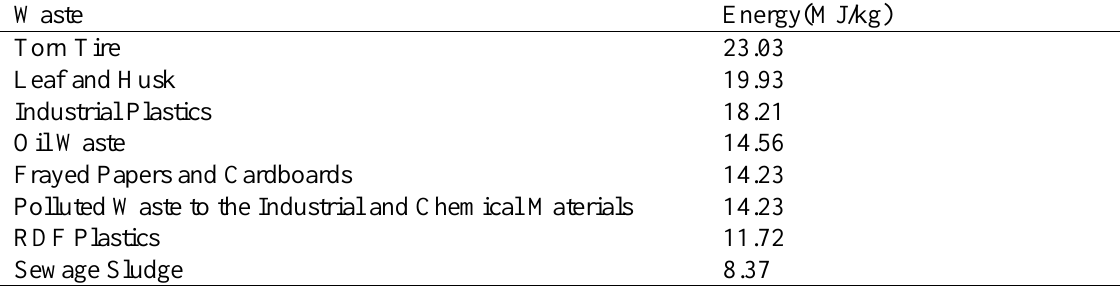
Table 3 . Heat values of different alternative fuels Waste